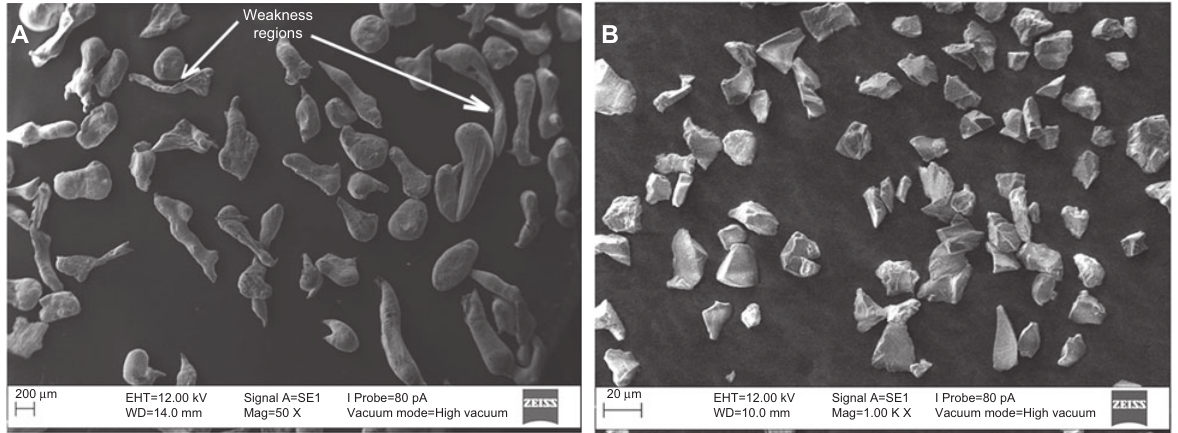
Figure 1 Morphology of as-received powders: (A) Al and (B) Al